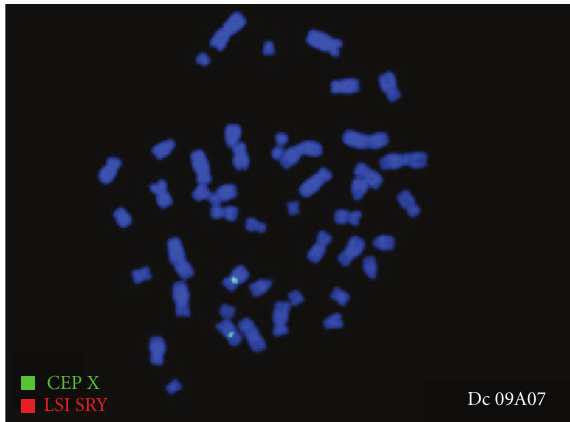
Figure 1: Fluorescence in situ hybridization FISH: the chromo- somes can be seen in blue LSI SRY: spectrum orange/CEP X: spectrum green. Presence of 2 green spots. No orange spot was detected.